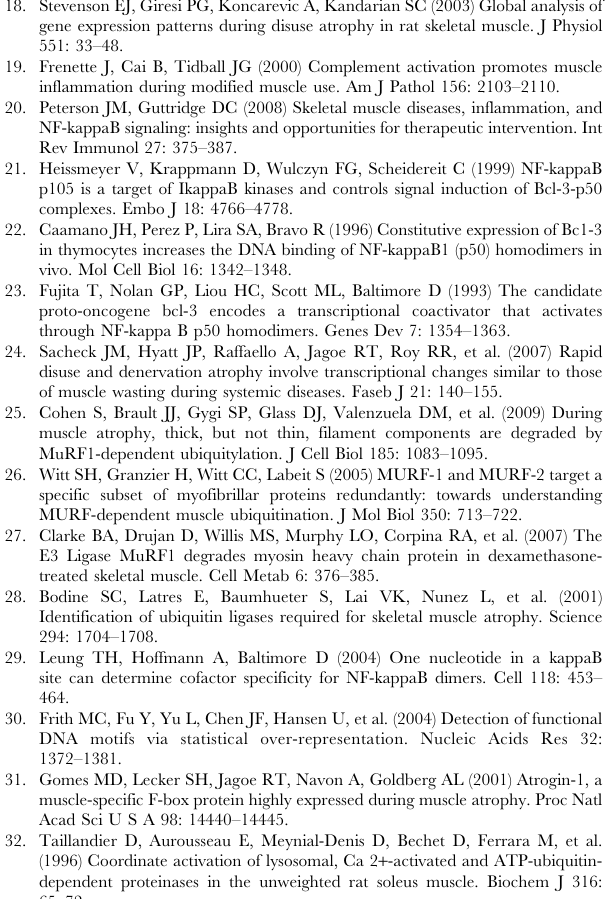
Table S3 TaqMan probes used for quantitative real